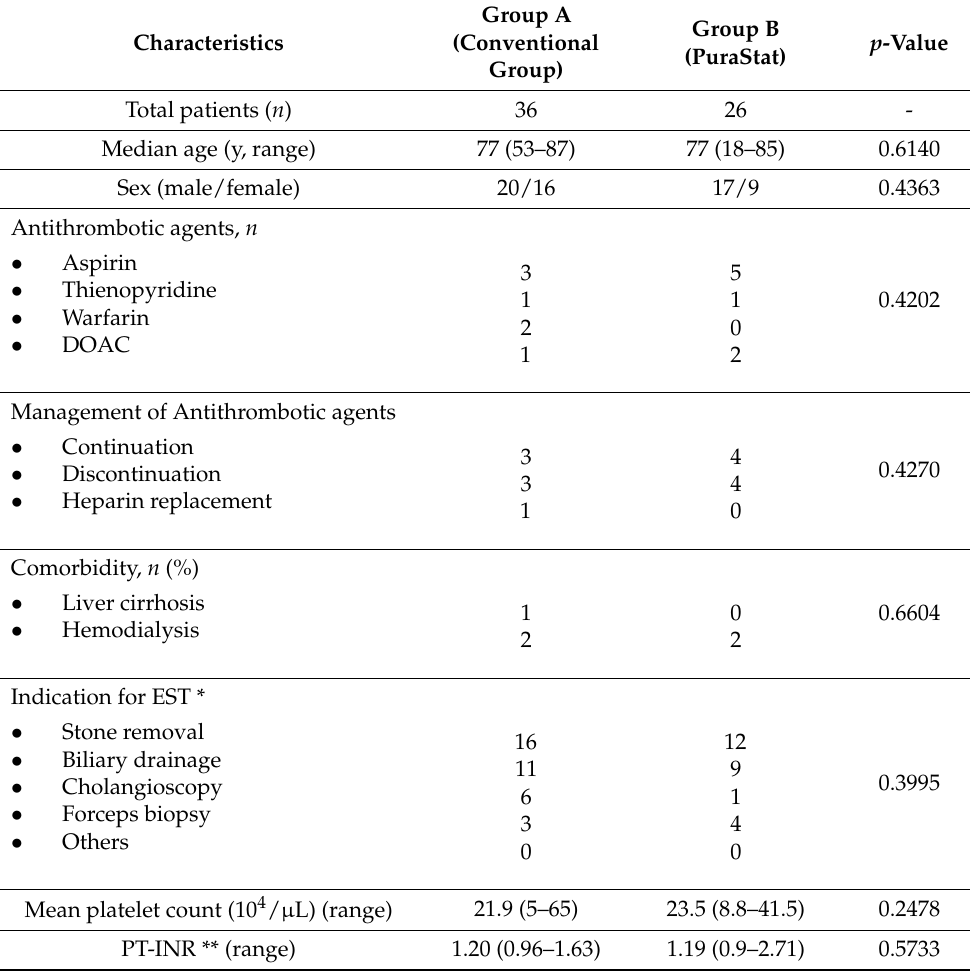
Table 1. Patient characteristics.